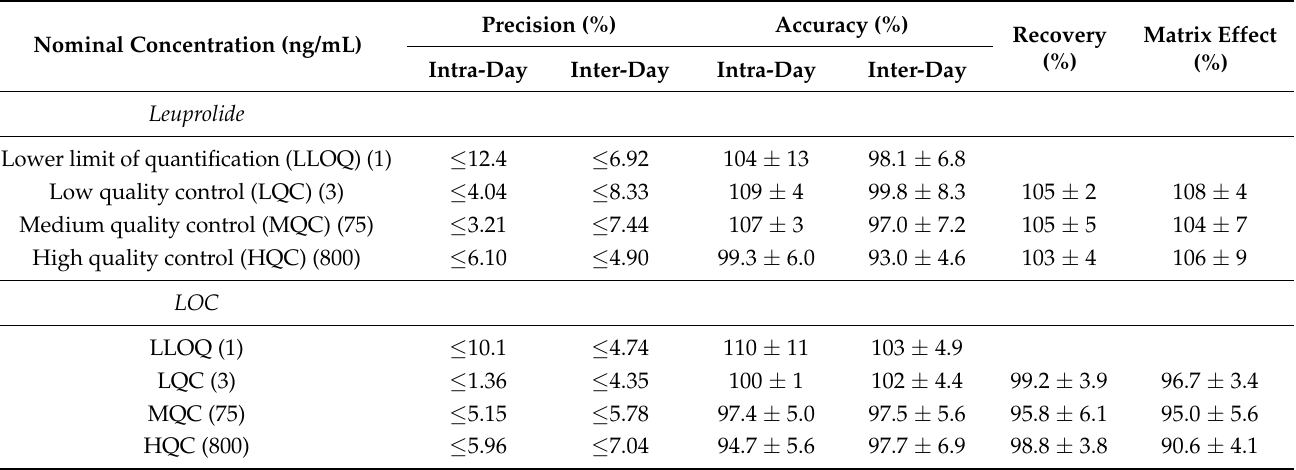
Table 1. Precision, accuracy, recovery, and matrix effect of liquid chromatography-electrospray ionization–tandem mass spectrometry (LC-ESI-MS/MS) analysis of leuprolide and leuprolide-oleic acid conjugate (LOC) in rat plasma samples ( n = 5).